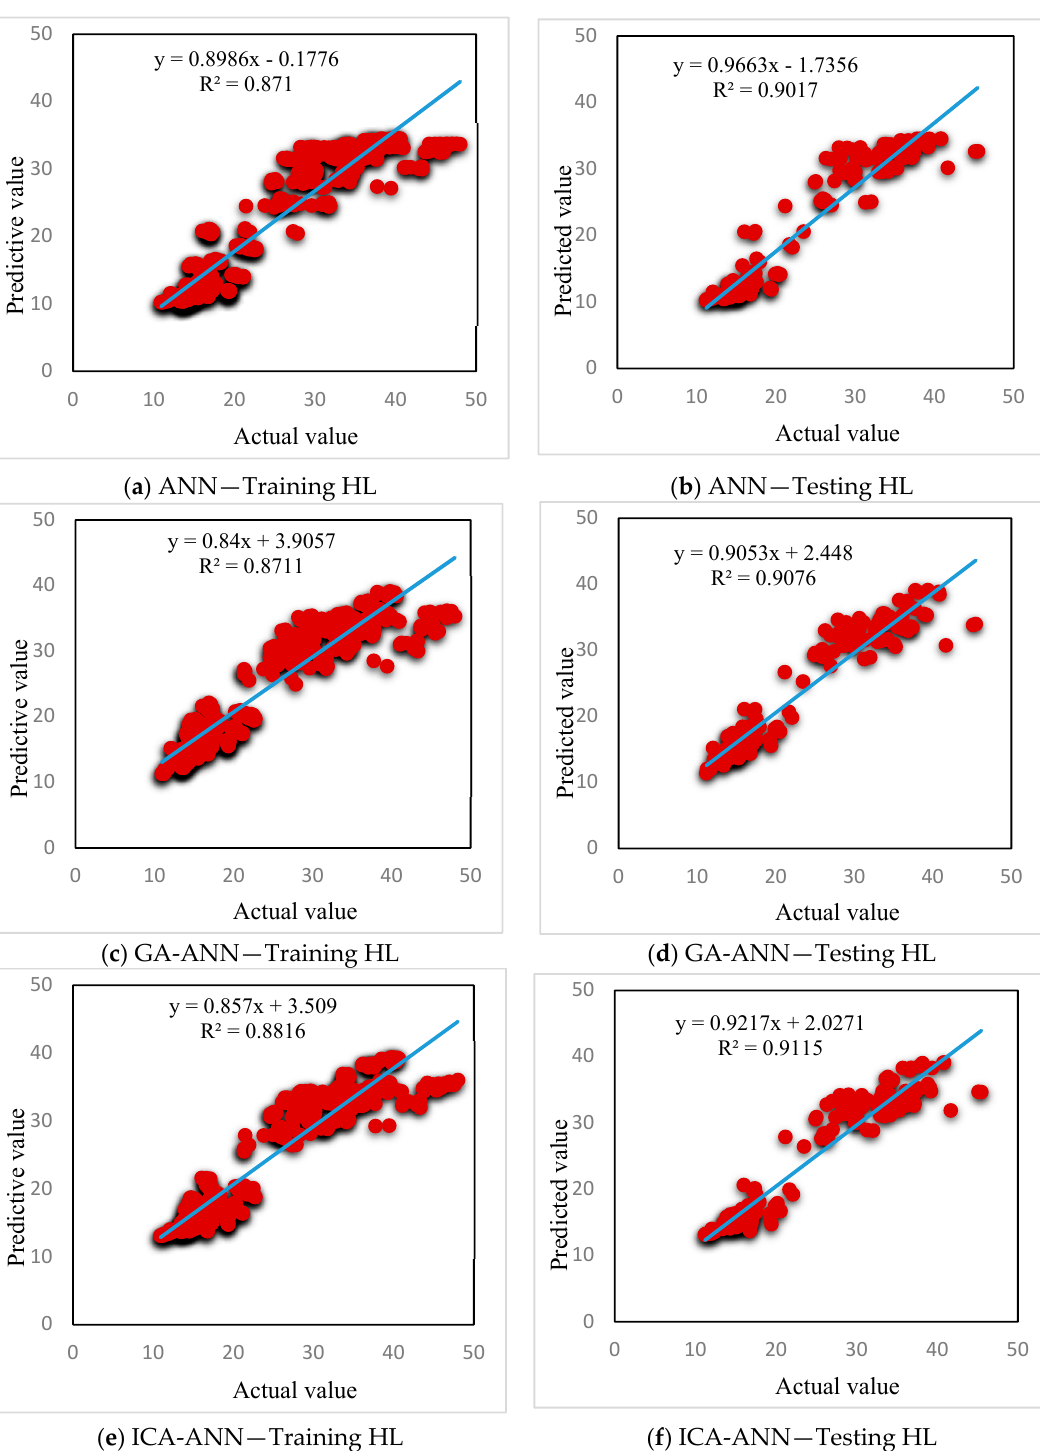
Figure 13. The regression between the actual and predicted HL.